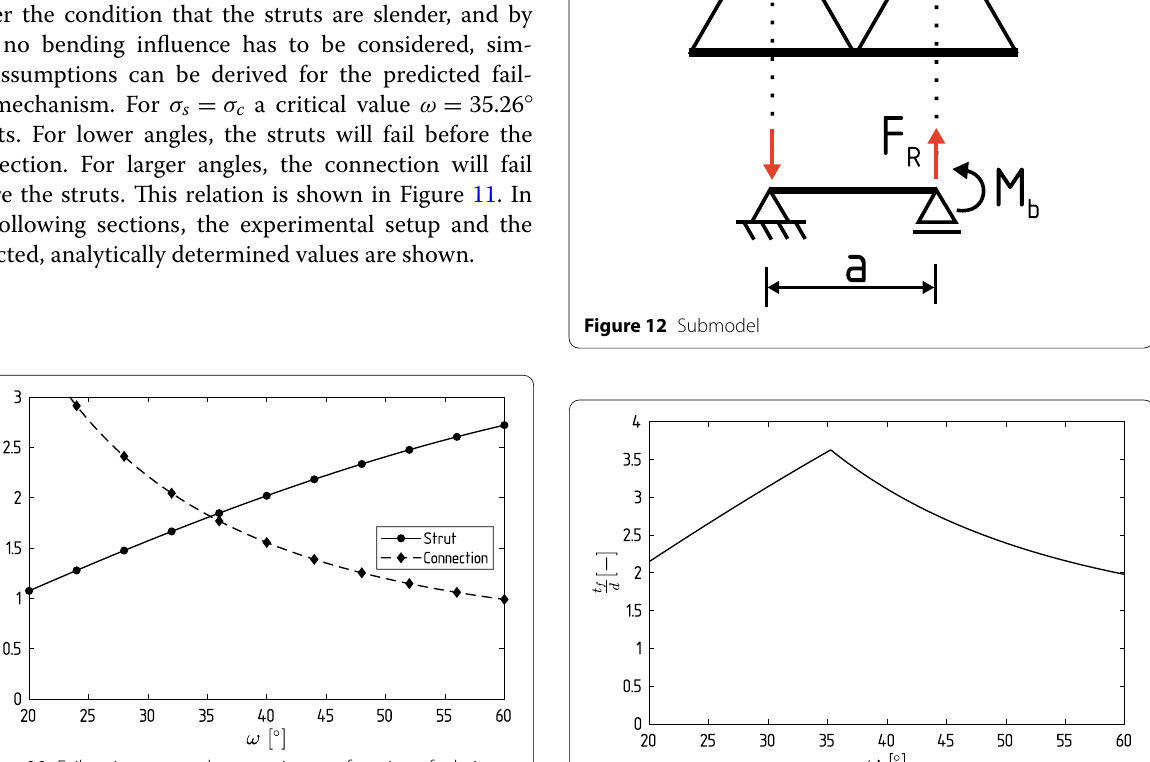
Figure 13 Critical ratio for t f / d to avoid